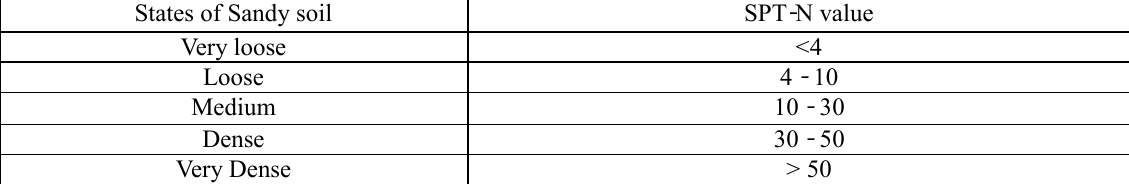
Table 3 SPT-N values for different states of sandy soils